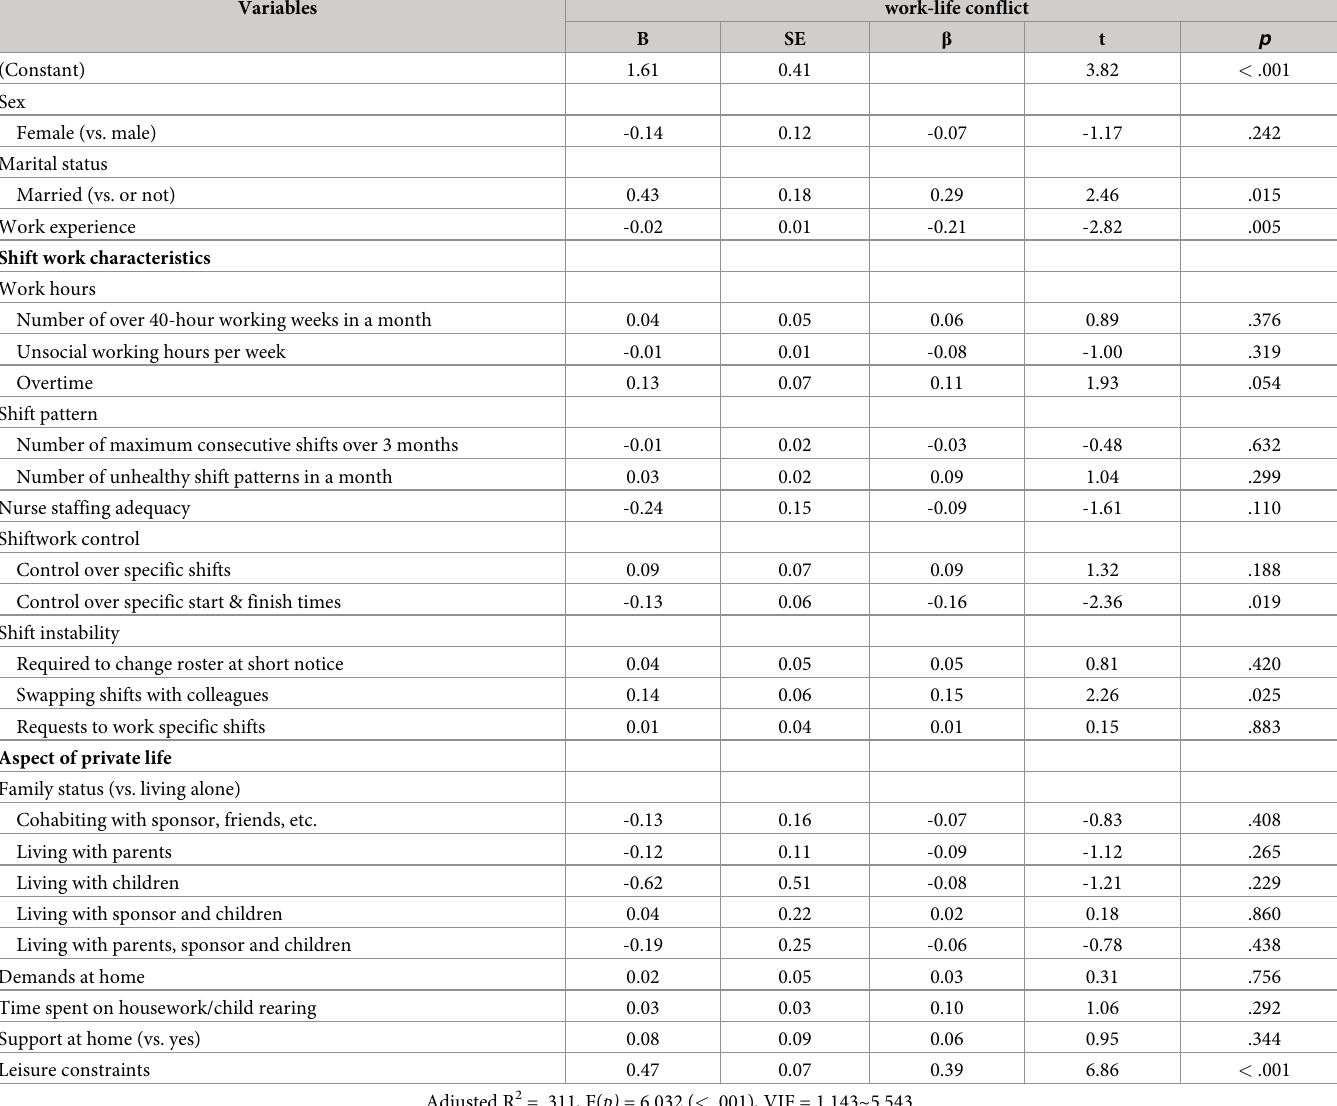
Table 4. Relationship between shiftwork characteristics, aspect of private life, and work-life